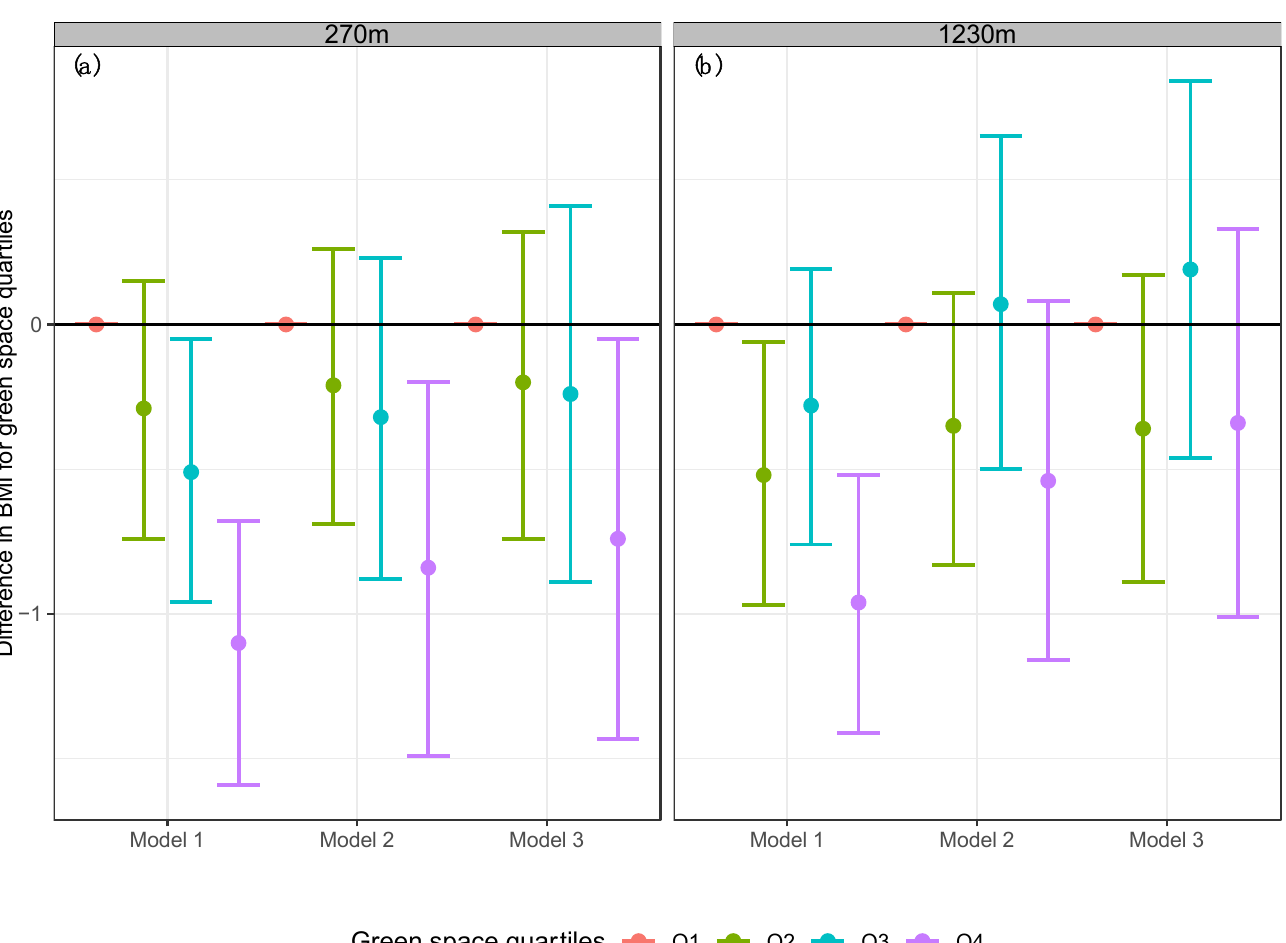
Figure 3. Linear models for BMI in the Mexican adult population by the difference quartiles of NDVI. ( a ) Buffer 270 m, ( b ) Buffer 1230 m. Model 1 = Linear regression model for BMI and NDVI. Model 2 = Adjusted linear regression model for BMI, NDVI, age, sex, area, region, socioeconomic status, and education level. Model 3 = Adjusted linear regression model for BMI, NDVI, physical activity, age, sex, area, region, socioeconomic status, and education level.